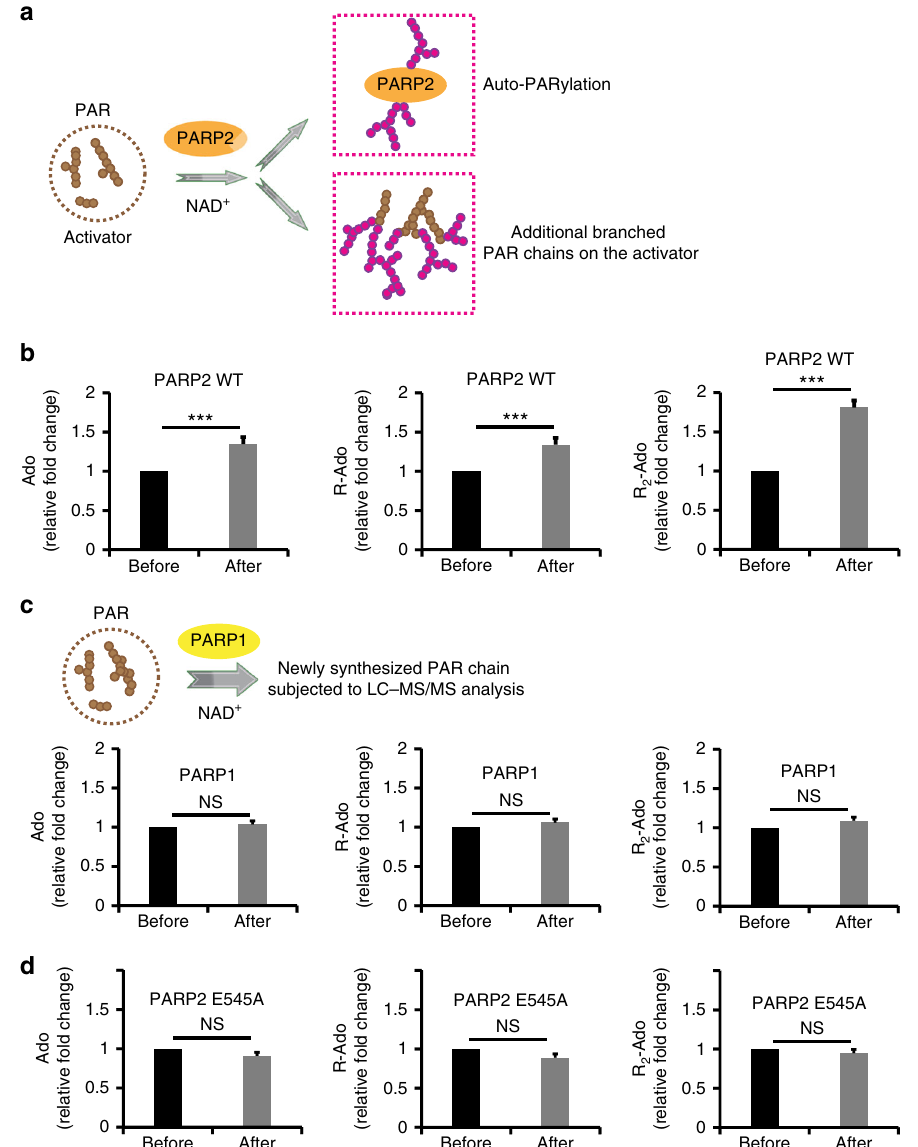
Fig. 2 PARP2 mediates the branched PAR chain formation. a A diagram of PARP2-dependent branched PAR chain formation. b PARP2 catalyzes branched PAR chain polymerization. The activator PAR was examined by mass spectrometry following the in vitro PARP2-dependent PARylation. c PARP1 cannot PARylate the existed PAR chains in the same tested condition as b . d The PARP2E545A mutant fails to catalyze additional PAR chains on the activator PAR. Data are represented as mean ± s.d. as indicated from three independent experiments. Signi fi cance of differences was evaluated by Student ’ s t -test. NS: non signi fi cant; ***statistically signi fi cant ( p <